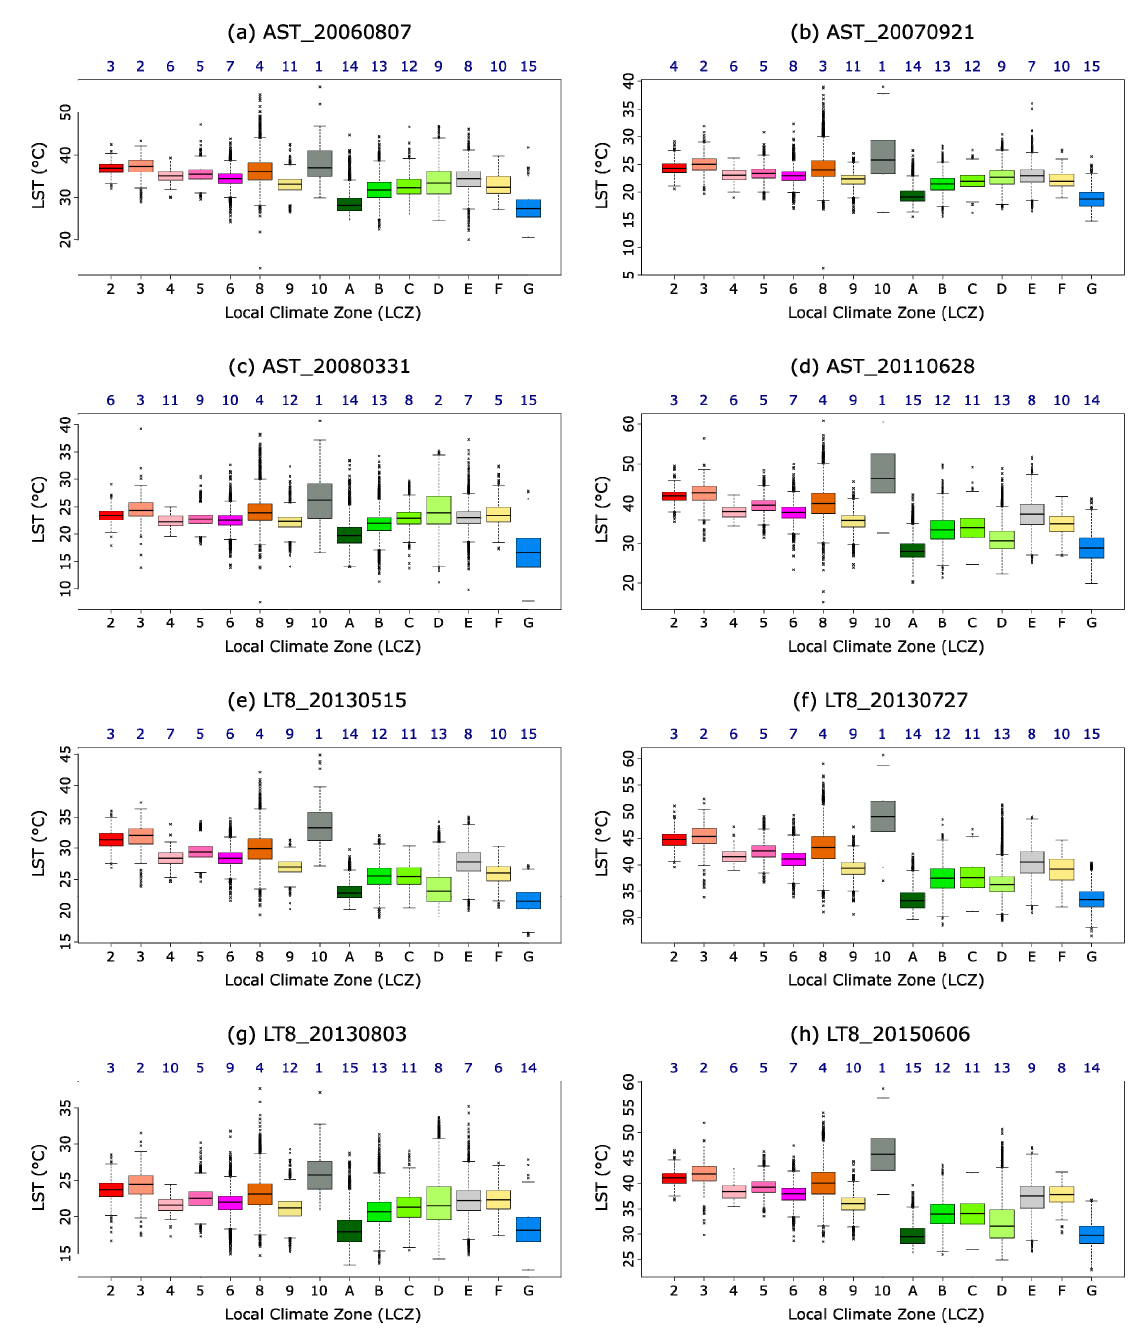
Figure 7. Box-plots with land surface temperature (LST) in LCZ classes in Prague for ASTER ( a – d ) and LANDSAT-8 ( e – h ) images; see Table 3 for the scene ID; for the explanation, see Figure 6.